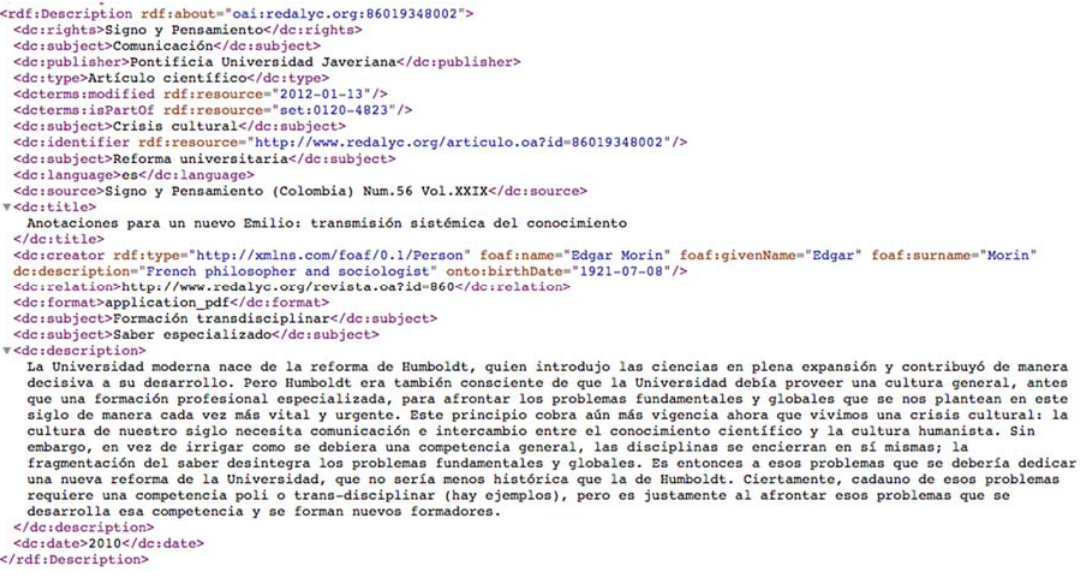
Figure 11. Example of enriched RDF.